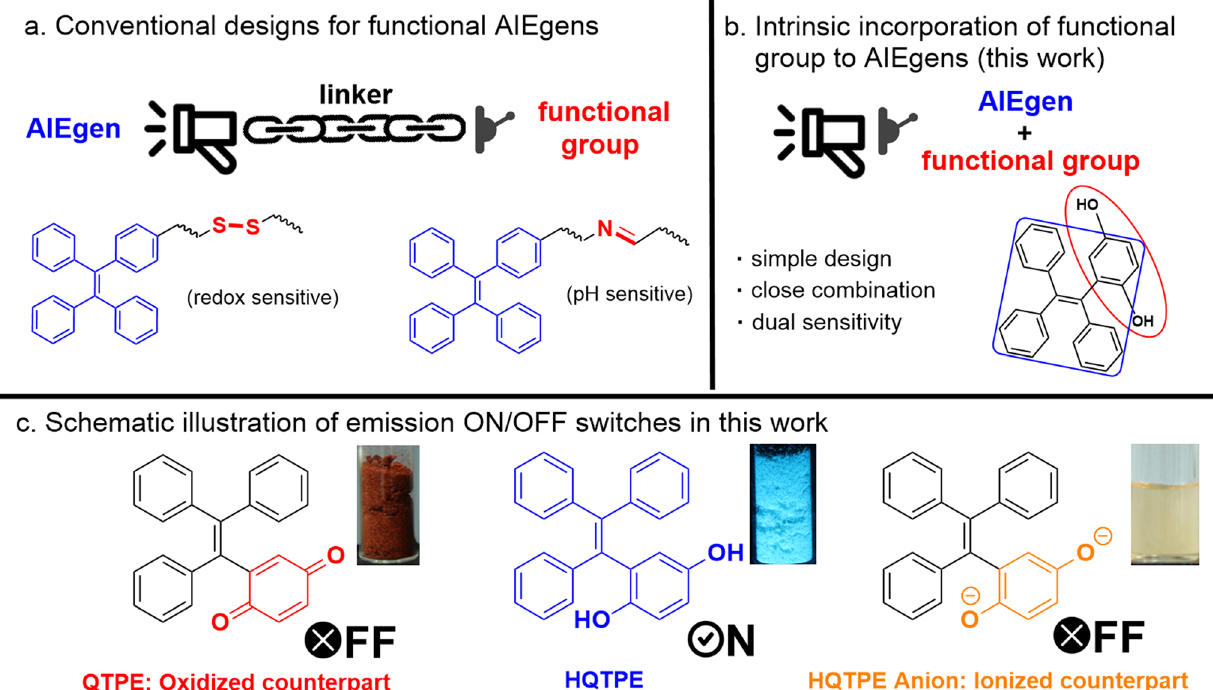
Fig. 1 Conventional designs and intrinsic functionalization for AIEgens. a Conventional designs for functional AIEgens. b Intrinsic functional AIE-active core in this work. The functional group hydroquinone and AIEgen TPE share part of the structure. c Schematic illustration of emission ON/OFF switches.